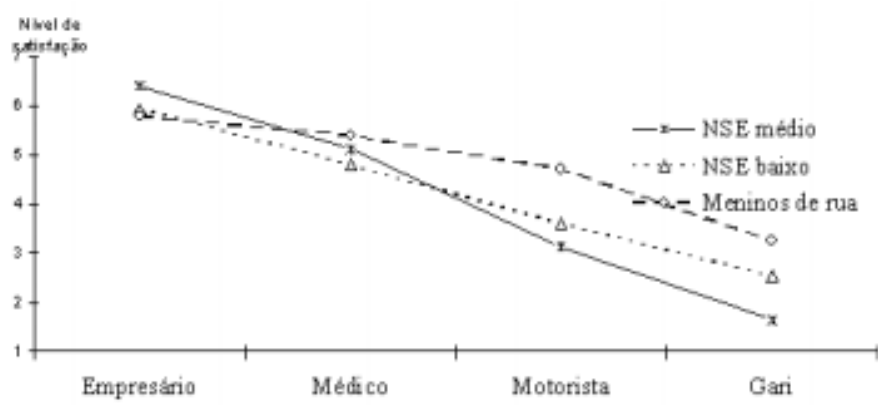
Figura 2 . Interação NSE x Ocupação.VD: Nível de satisfação na questão